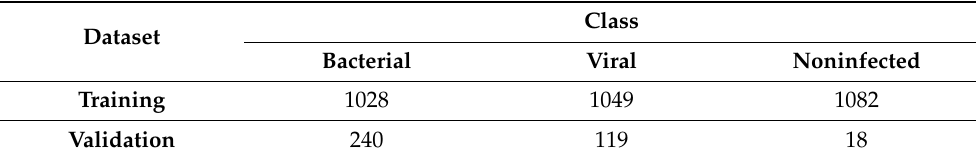
Table 1. Number of samples used in datasets for training and validation to assess the performance of the original and swapped marker